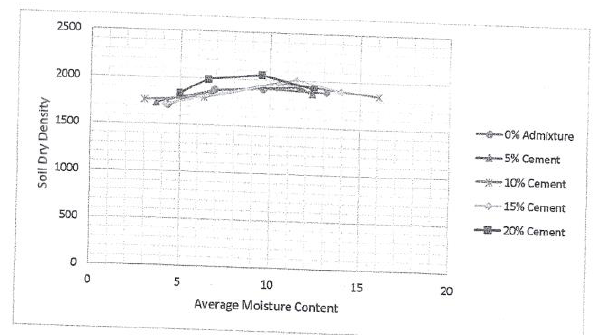
Figure 5: Particle Size Distribution Chart for Point 5